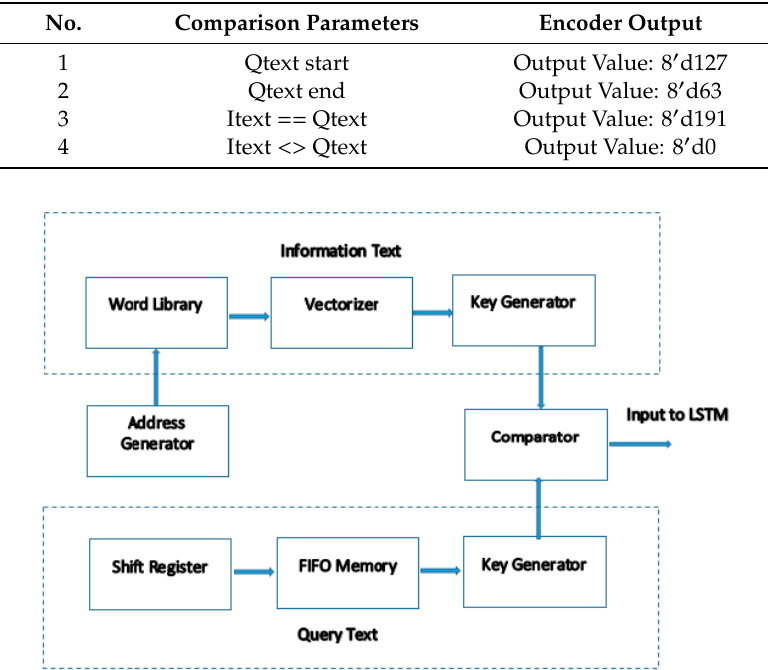
Figure 7. Process flow diagram of the key encoder.